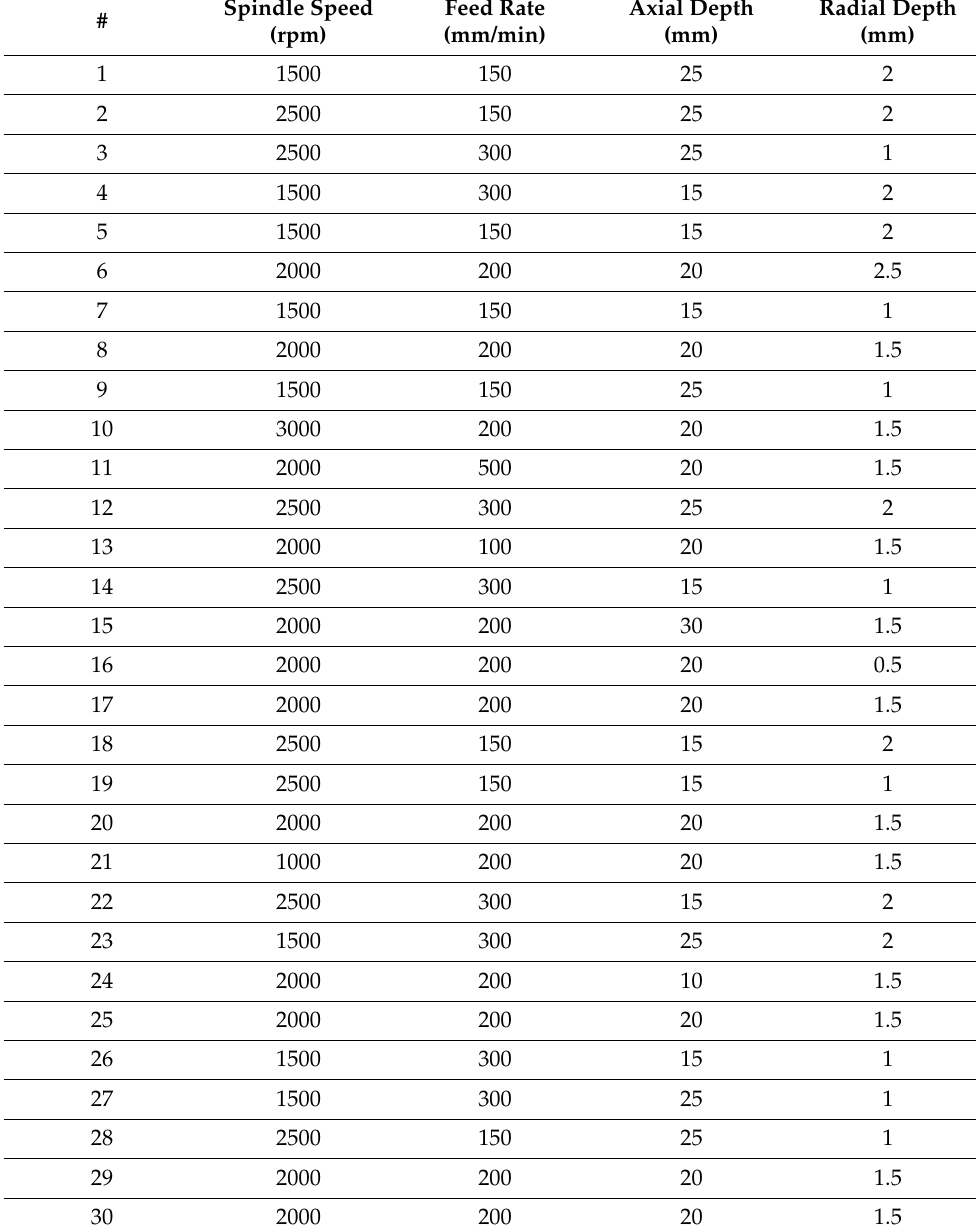
Table 1. Experimental